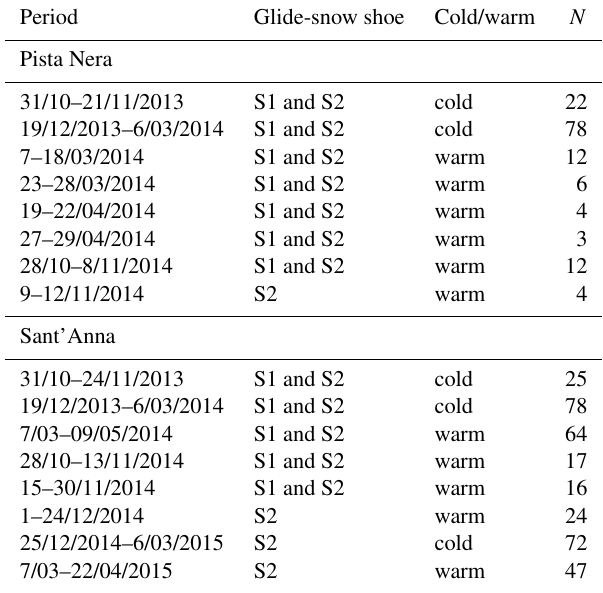
Table 1. Periods of analyses for each single glide shoe at the two test sites during the two monitoring seasons. Dates are in day/month/year; N indicates the number of data in the correspond- ing